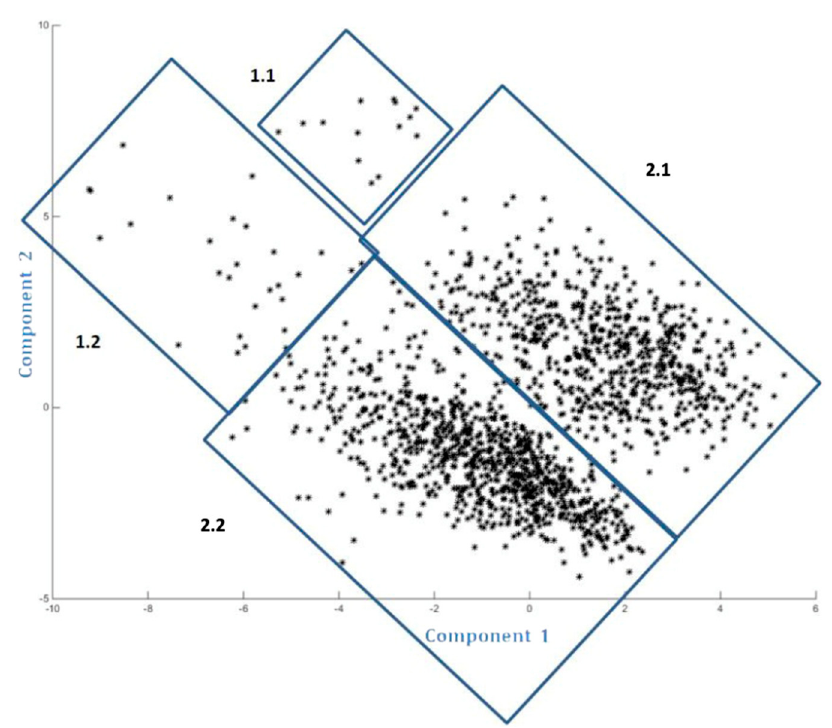
Figure 1. Results of the principal components analysis (PCA) analysis of the available data.